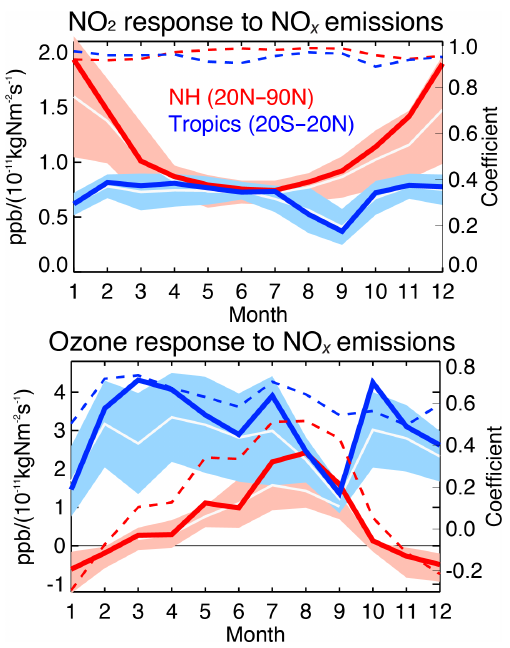
Figure 15. Time series of model response of surface ozone and NO 2 concentrations to NO x emissions estimated from linear regres- sions using the multi-model integrated fields in 2007 over areas with NO x emission changes greater than 5 × 10 − 13 kgNm − 2 s − 1 for the Northern Hemisphere (20–60 ◦ N, red line) and the tropics (20 ◦ S– 20 ◦ N, blue line). The ± 1 σ deviation among the four models (i.e., model spread) is shown in light red for the NH and in light blue for the tropics. The multi-model mean value (i.e., an average of indi- vidual estimates) is shown by white lines. The correlation is shown by dashed